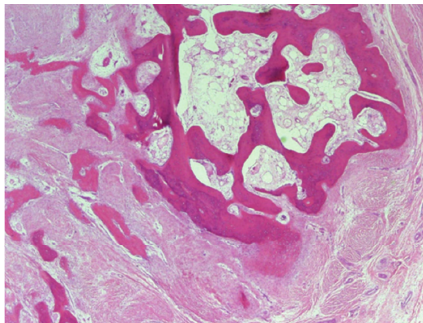
Figure 17: Light micrograph of the osteocartilaginous interface of the lesion showing disorganized cartilage with irregular ossification (hematoxylin and eosin stain; original magnification × 200).